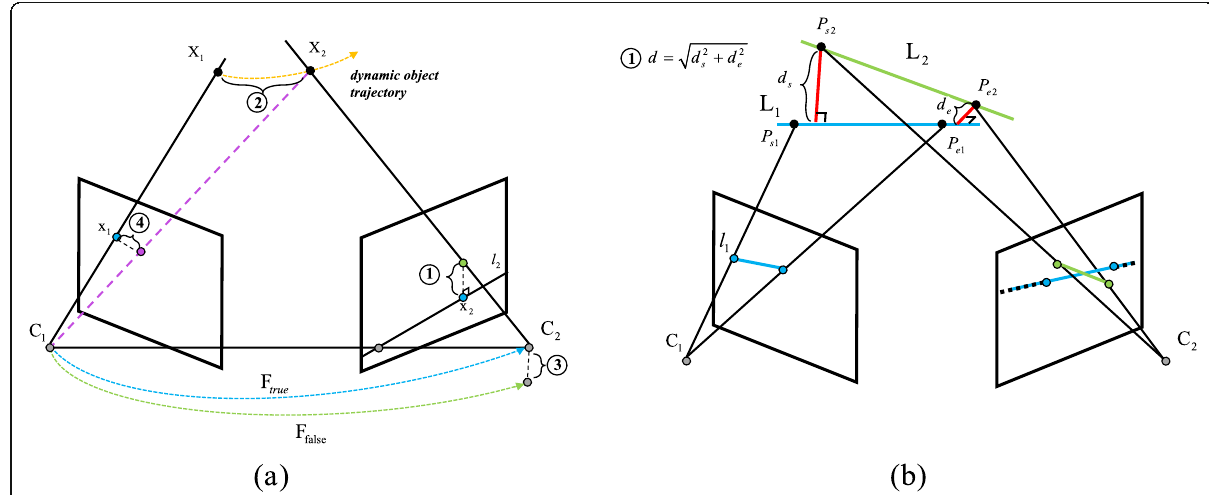
Fig. 1 ( a ): The violation of geometric constraints for point features in dynamic environments: (1) the tracked feature lies too far from the epipolar line, (2) back-projected rays from the tracked features do not meet, (3) faulty fundamental matrix estimation occurs when a dynamic feature is included in pose estimation, (4) high distance between re-projected features and observed features [16]; ( b ): The violation of geometric constraints for line features in a dynamic environment: (1) the matched 3D line (green) lies too far from the predicted 3D line